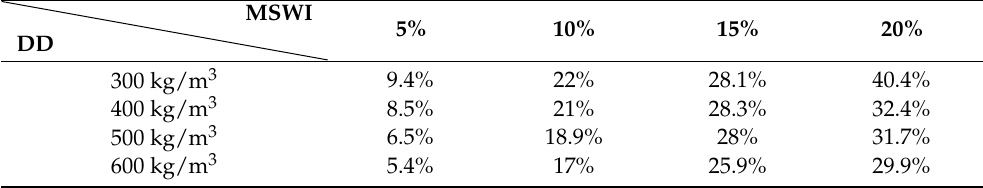
Figure 6. Compressive strength of the recycled foamed concrete with different MSWI micro- powder contents. Table 3. Change rate of the compressive strength at different dry